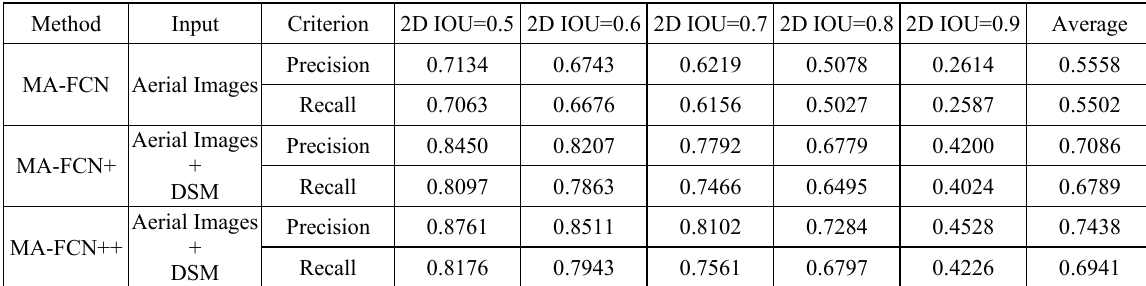
Table 1. The comparison of different building footprint extraction methods.